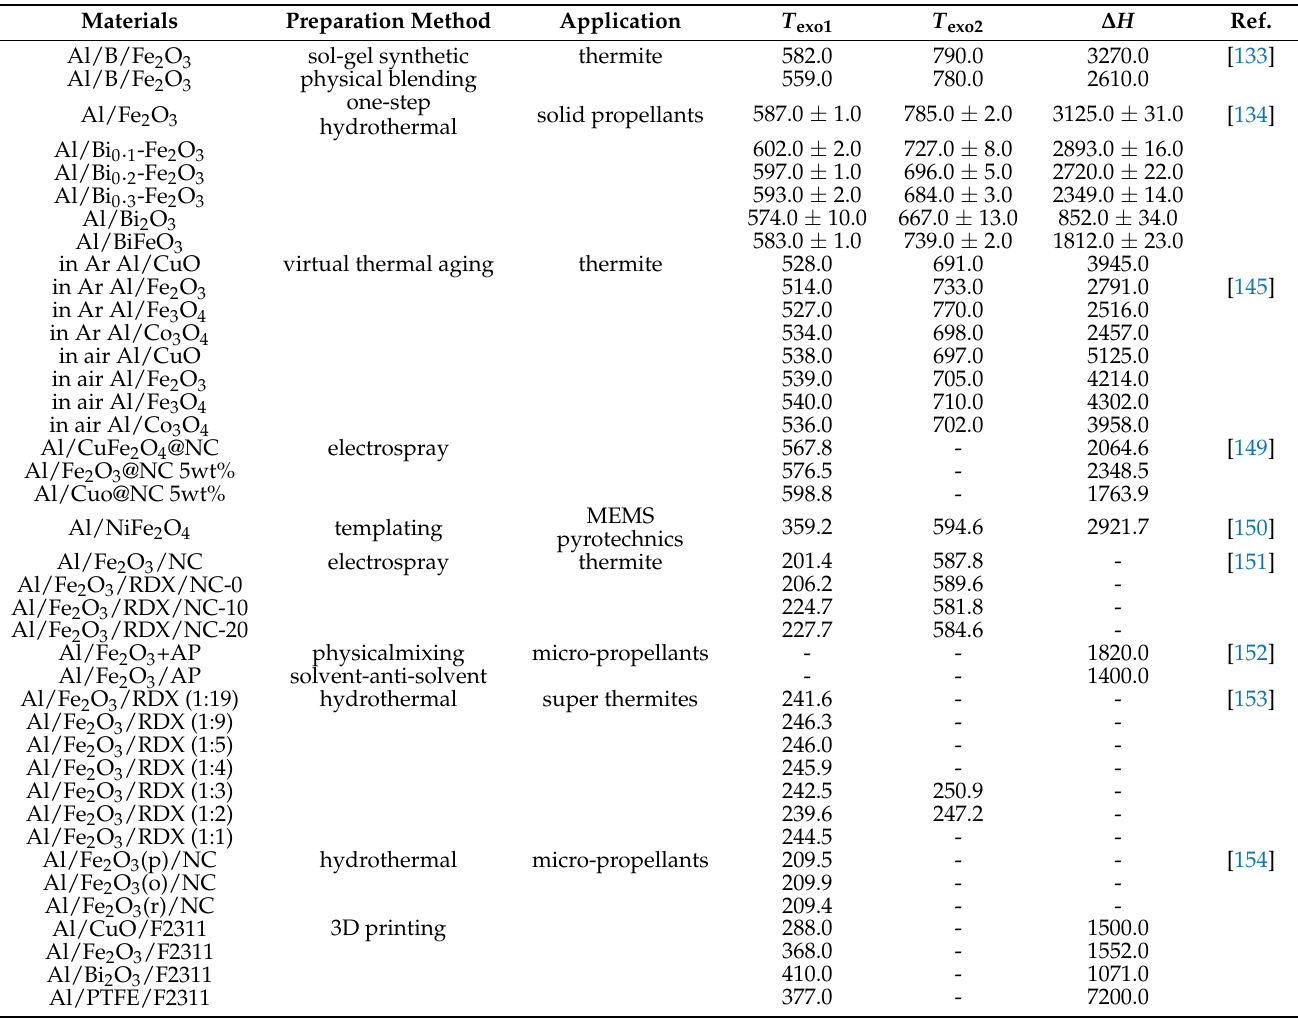
Figure 38. ( a ) SEM images of Al/Fe 2 O 3 /F2311; ( b ) DSC curves of Al/Fe 2 O 3 /F2311. ( a , b ) Reproduced with the permission of ref. [155]. Copyright 2021, Materials Chemistry and Physics. Table 4. Parameters of some